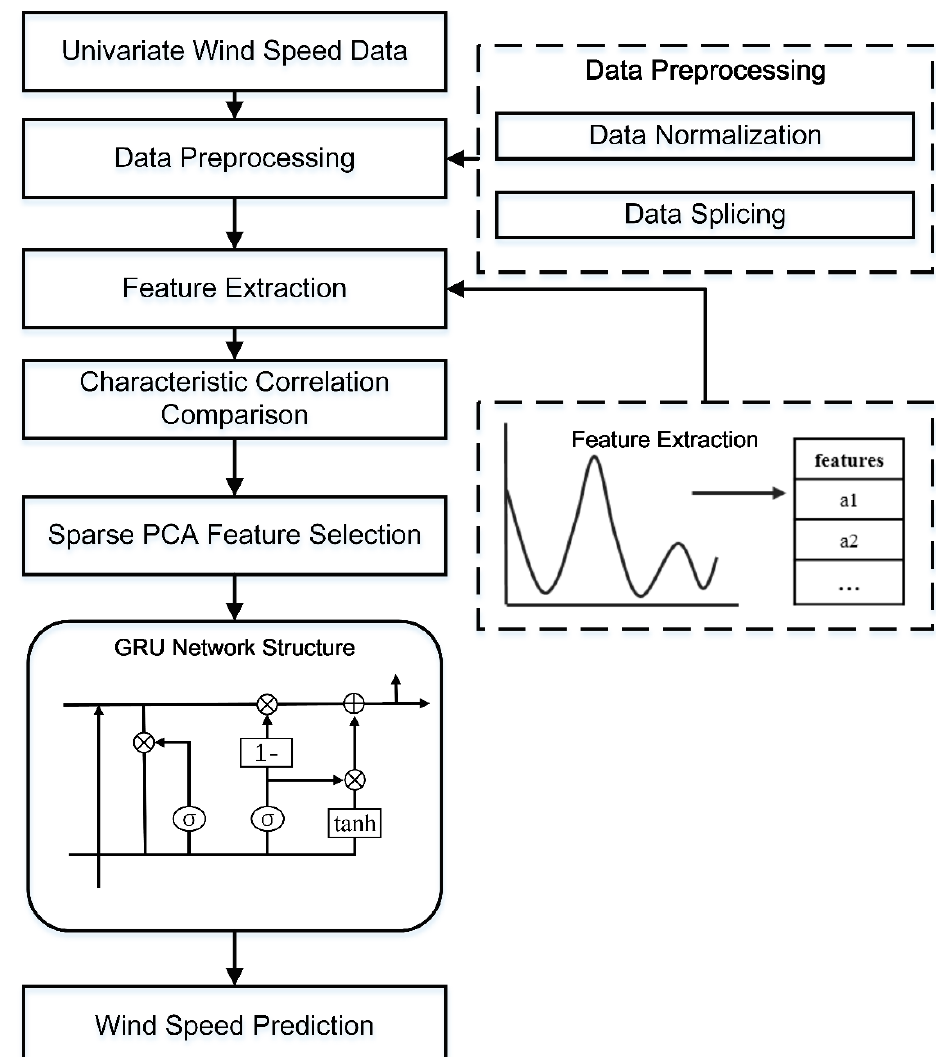
Figure 3. Flow chart of the prediction method framework. The hybrid model preprocessed the original univariate wind speed time series data, and the processing included data normalization and data binning. Feature processing was performed on the data, including feature extraction and feature selection. Finally, all feature data were predicted using a GRU network.